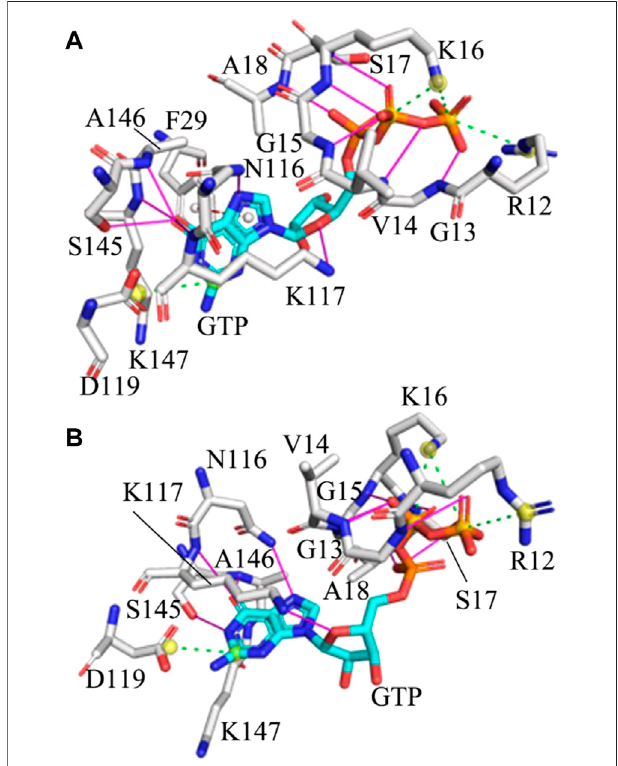
FIGURE3| InteractionnetworkofGTPwiththeG12RKRAS: (A) and (B) respectively corresponding to interactions of GTP with key residues in the situation of the most incompact and tightest switch domains. Hydrogen bonding interactions, salt bridge and π - π interaction are indicated in the magenta full line, green dot line and red dot line,